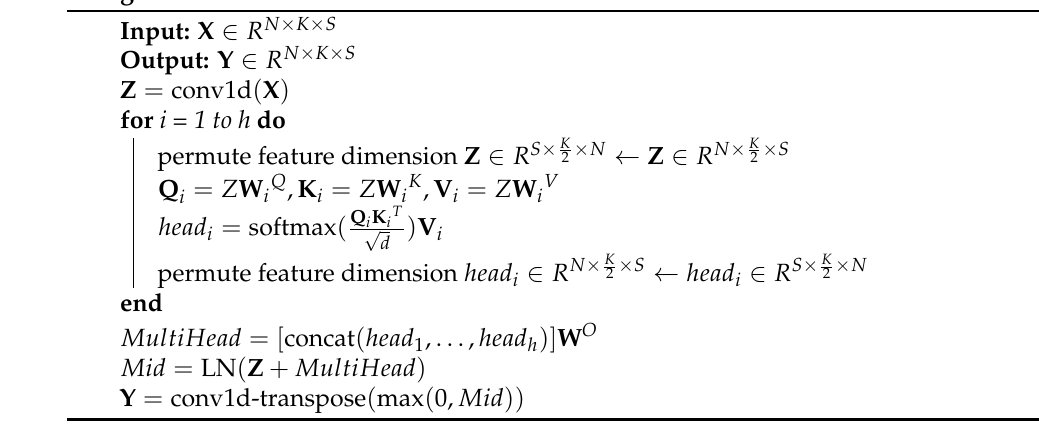
Algorithm 1: DPTTNet block